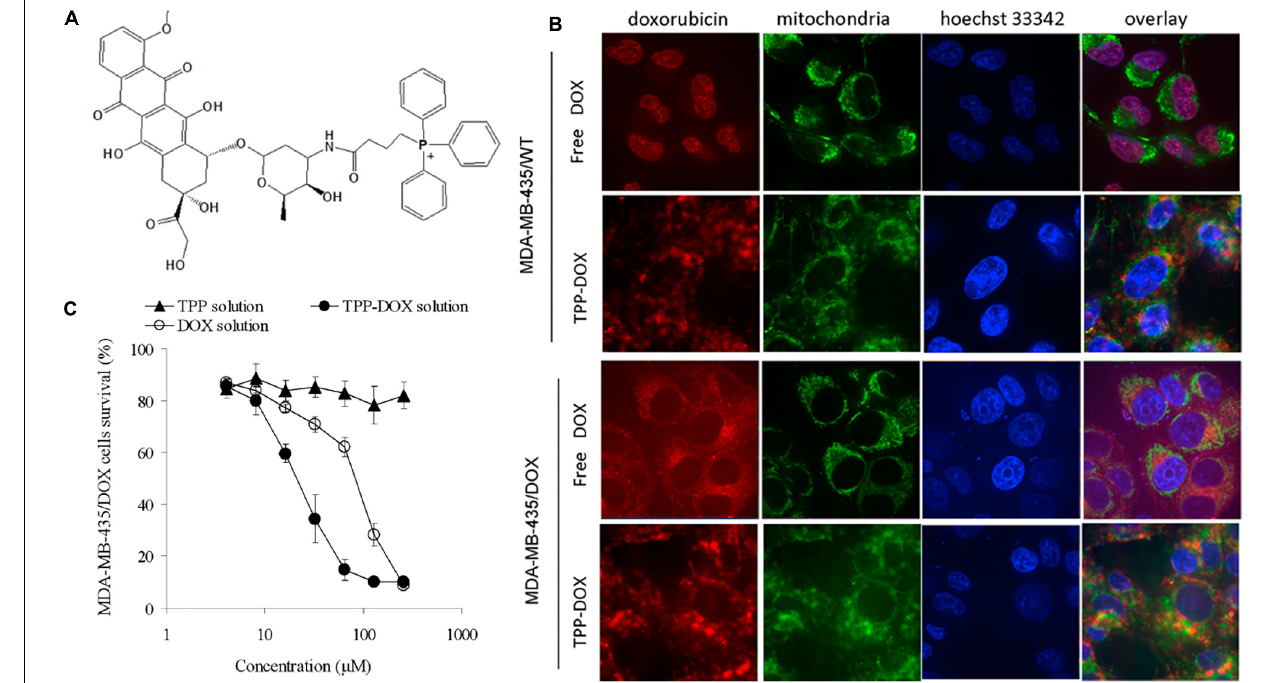
Frontiers in Pharmacology |